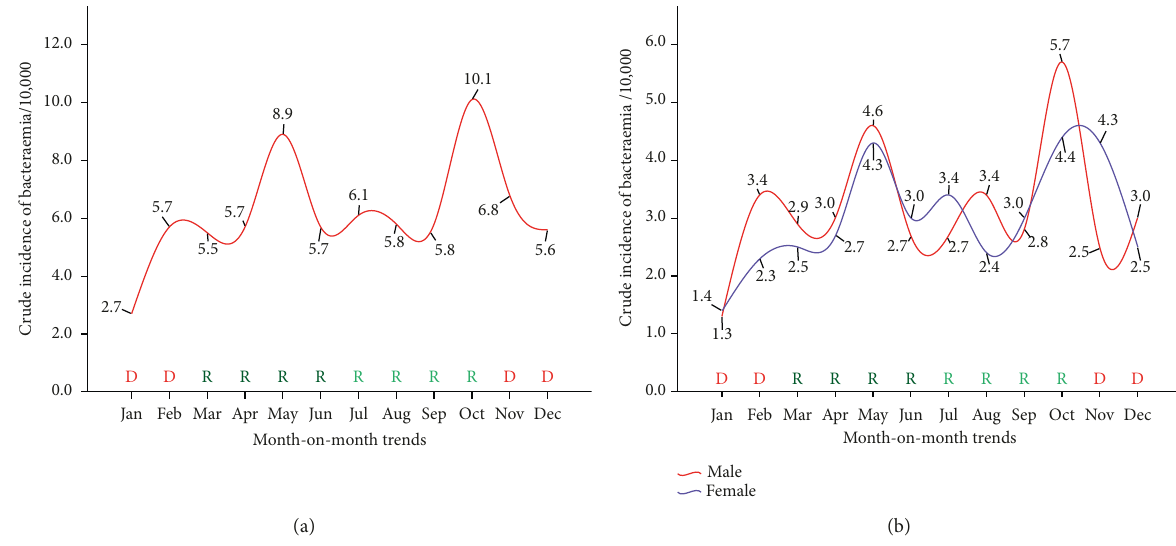
Figure 3: Seasonal variation in bloodstream bacteraemia among patients attending St. Dominic Hospital in Akwatia. D, dry season; R (deep green), major rainy season; R (light green), minor rainy season. (a) Trend among all patients/10,000 persons. (b) Gender-specific trend among patients/10,000